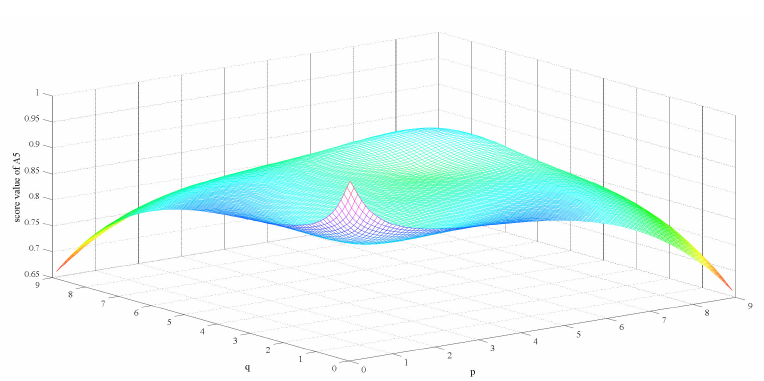
Figure 5. Score value of disposable medical mask ( A 4 ) when p , q ∈ [ 0.1,9 ] .